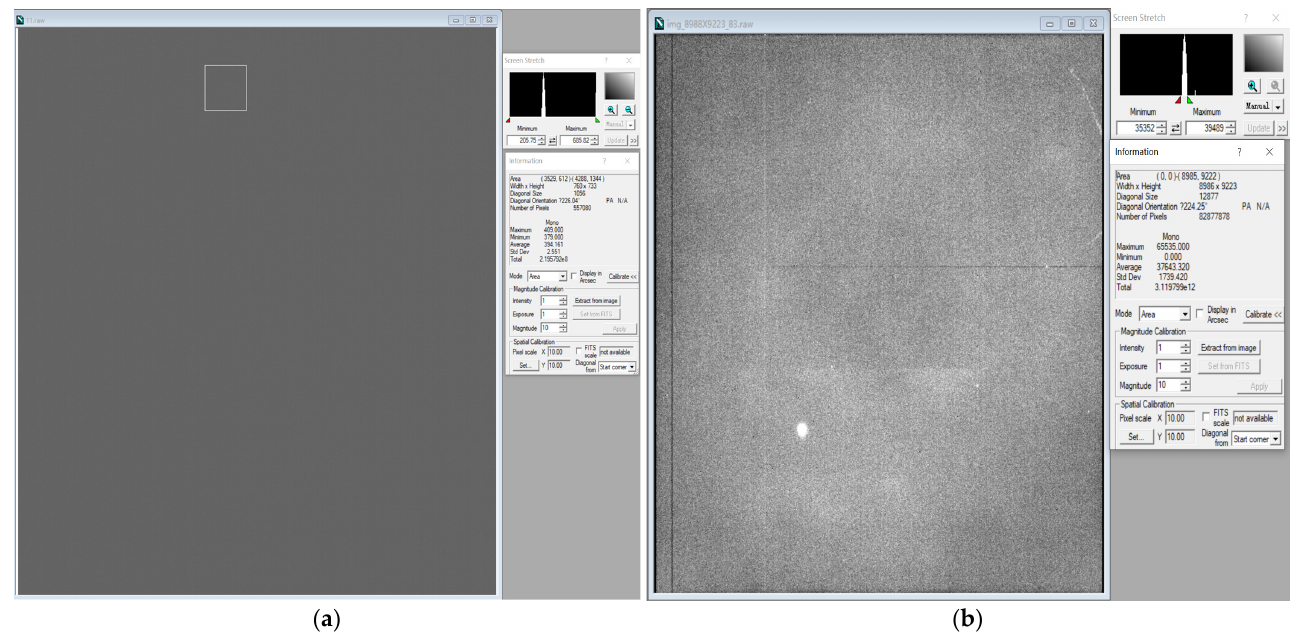
Figure 11. Test at room temperature. A dark and a flat image. ( a ) Dark image ; ( b ) Flat image. The main test result at room temperature is that the readout noise is about 4.4e − , the reading interval is 2.94 s, so the fps (frames per second)) [14] is 0.34. We also used this camera to take a star map image ; the star map image is shown in Figure 12.